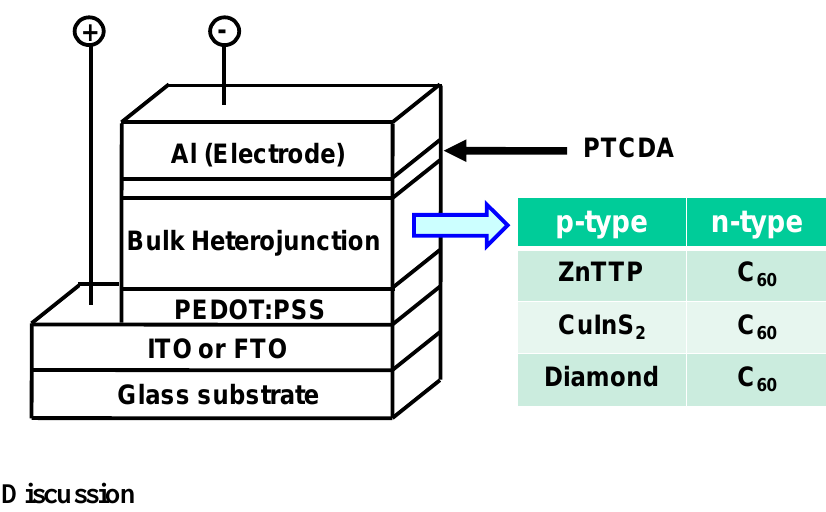
Figure 1. Structure of C -based bulk heterojunction solar cells with PTCDA layer. 60